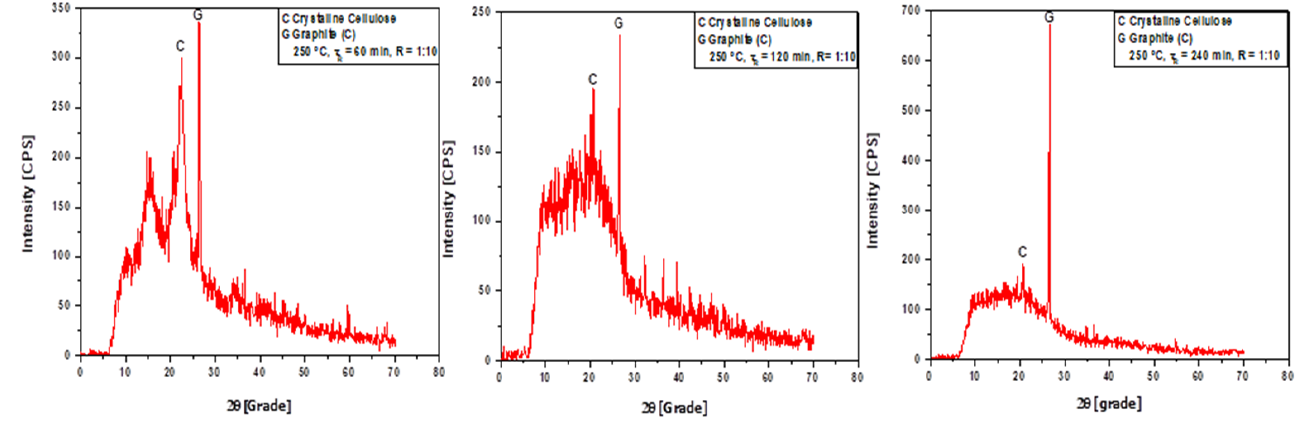
Figure 11. XRD of hydro-chars obtained by the hydrothermal processing of corn stover at 250 °C with a biomass/H 2 O ratio of 1:10 after 60, 120 and 240 min using a reactor of 18.75 L.